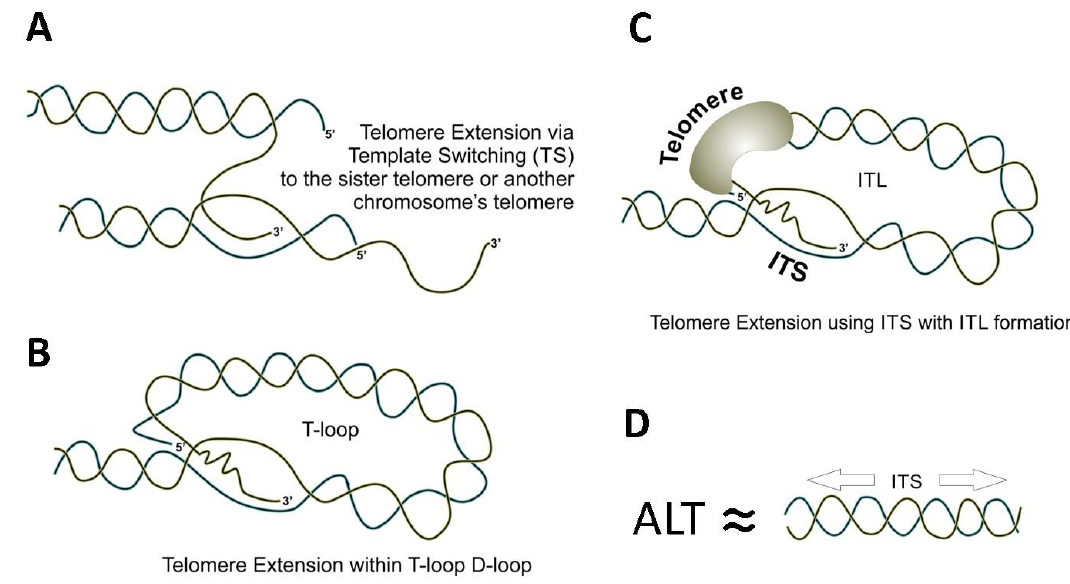
Figure 5. Alternative lengthening of telomeres and ITSs. ( A ) ALT is a process that relies on Template Switching (TS) and is thought to be initiated by replication blockage or a break in the DNA. The strand exchange reaction performed by specialized enzymes (e.g., TS helicases) or HR-proteins is followed by the DNA synthesis performed in BIR-like manner. The source for the template could be either the sister telomere or a telomere on another chromosome. ( B ) Extension mechanism via intratelomere invasion is also discussed [50,228]. ( C ) Another striking possibility is the usage of ITSs for telomere extension. In this case, an Interstitial t-loop (ITL) should be formed. The extension might occur via multiple cycles of invasion or DNA slippage. ( D ) Key components participating in ITS expansion are relevant for the ALT process [300], hence these two processes share certain similarities. An exciting prediction from this model is that ITS’s length destabilization can be an indicator of activated ALT.